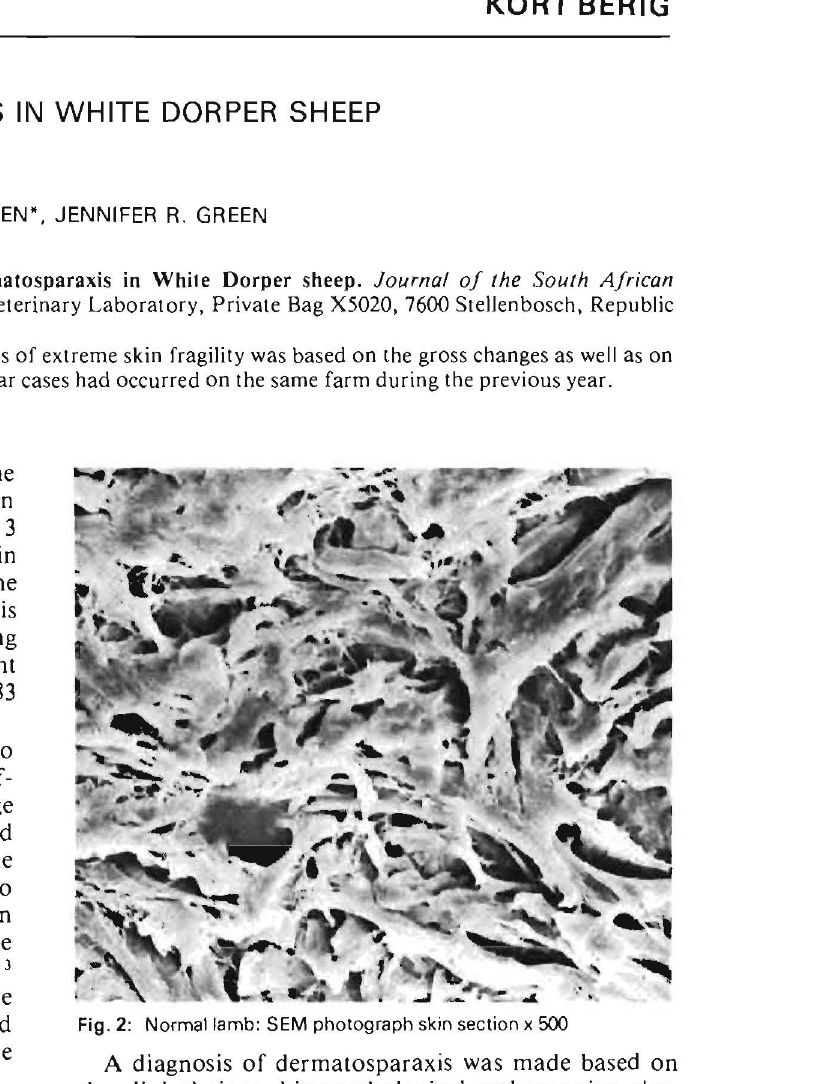
Fig.2: Normal lamb: SEM photograph skin section x 500 A diagnosis of dermatosparaxis was made based on the clinical signs, histopathological and scanning elec tron microscopical observations.] 23. This is a sim_ple, autosomal, recessive hereditary condition that has been described in cattle, sheep and dogs] 2. Skin fragility is caused by impaired collagen synthesis arising from an enzyme deficiency for the conversion of procollagen to collagen] 2. As far as is known it is the first report of der matosparaxis in White Dorper. Hypermobility of the joints as described by McOrist et a1.) has not been observed in affected sheep. Further cases have subse quently been reported from two other White Dorper